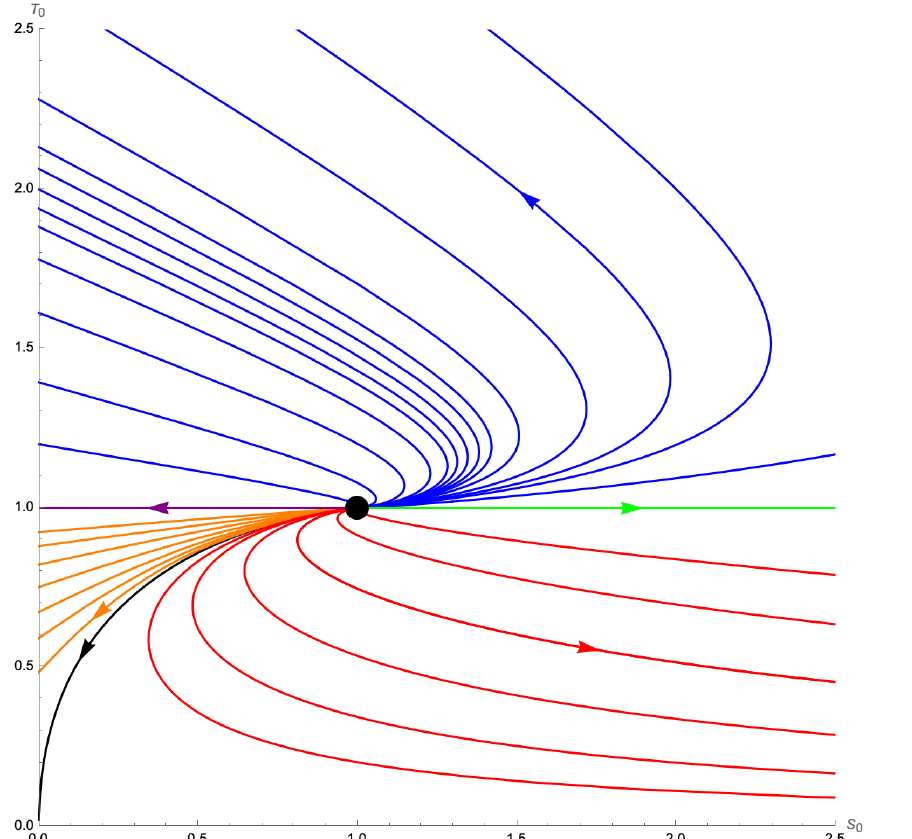
Figure 9 . Analytic behaviour of the near horizon electric flow for small perturbations of the RN fixed point with Φ 0 = 1 . The various colors correspond to different choices for c and the branches P ± and are detailed in the main text. The arrows point in the direction of the flow, while the black dot highlights the fixed point. The near horizon magnetic flow can be obtained by reversing the arrows and swapping S 0 and T 0